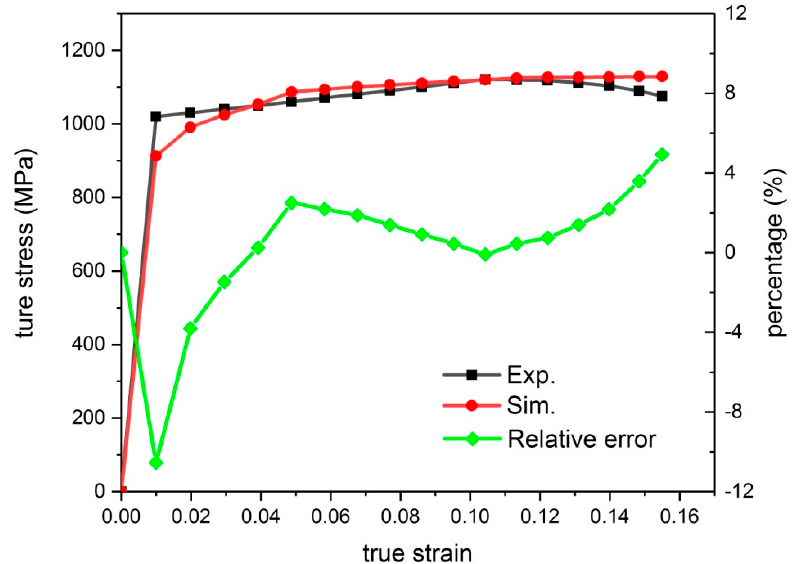
Figure 5. Comparison of true stress–strain curves and the relative error of experiment and the CPFEM simulation.